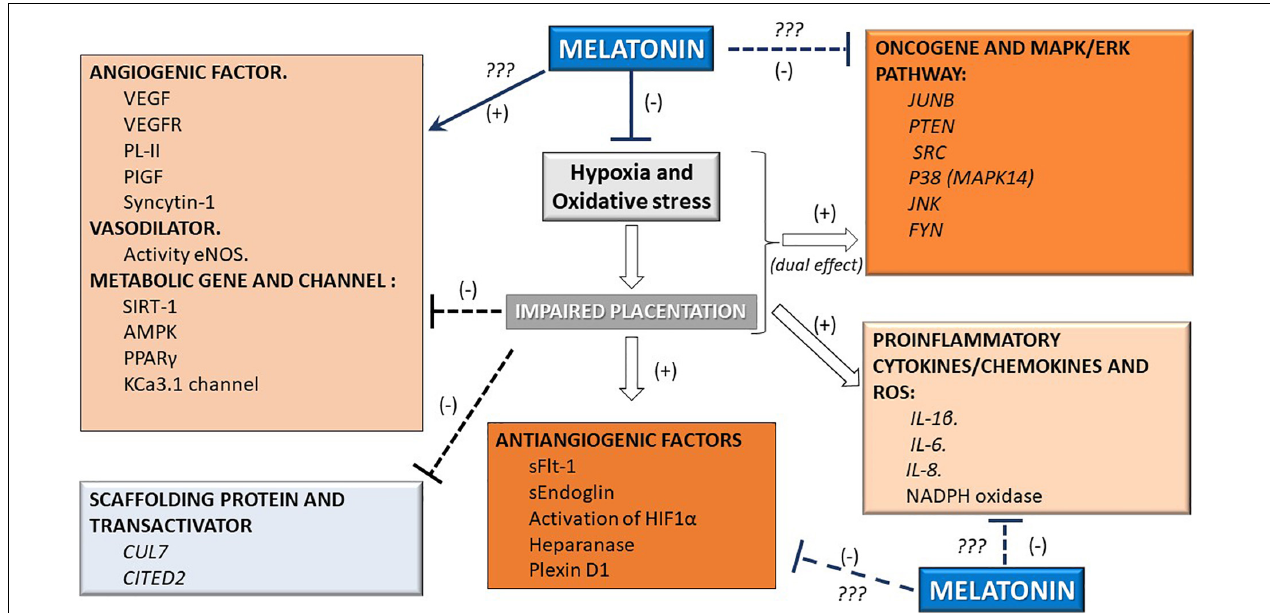
FIGURE 2 | Melatonin can modify molecular pathways in the placenta. Given the supraphysiological effect of the melatonin hormone, several pathways that affect vascular function are inhibited (-) or stimulated (+) in the placenta. These effects involve the hypoxia, pro/antiangiogenic, vasodilatory, metabolic, oncogenic, antioxidant, and proinflammatory